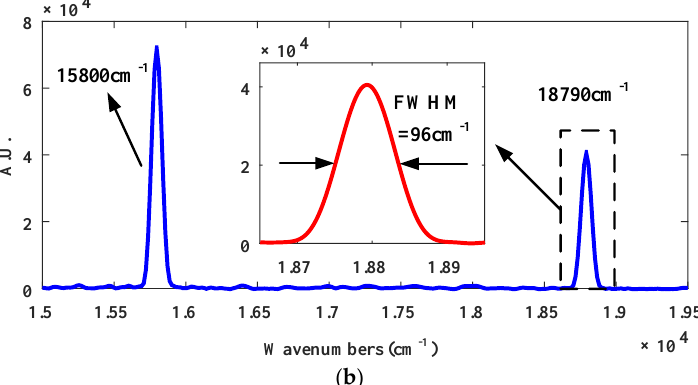
Figure 23. Under H∞ control: ( a ) the reconstructed interferogram of the testing light in spatial domain testing light; ( b ) spectrum recovered of the testing light.